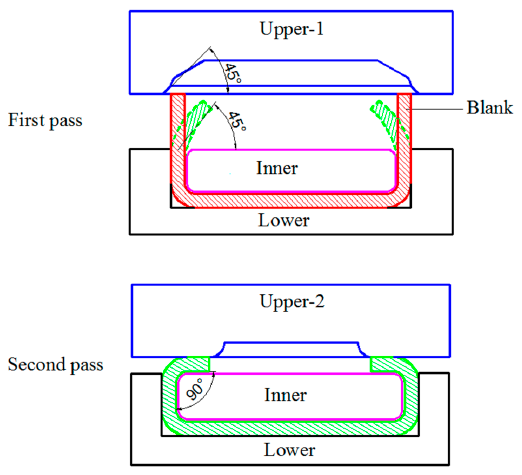
Figure 2. Stamping and bending forming process of concave ring.